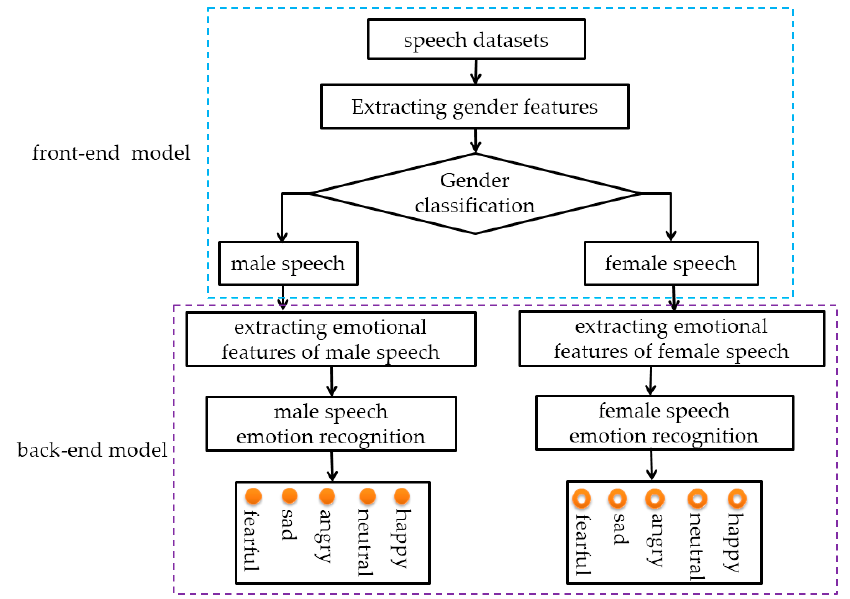
Figure 1. Framework of speech emotion